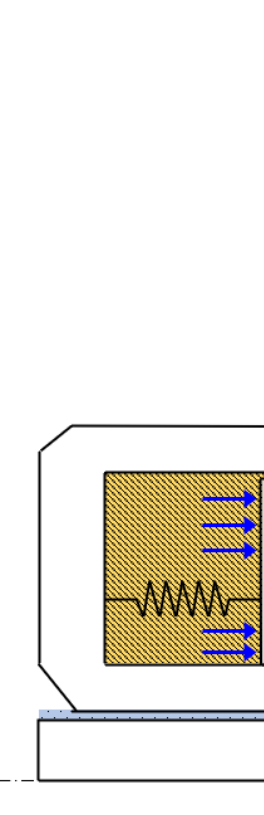
Figure 1. Seal structure and pressure boundary of a dry gas seal.